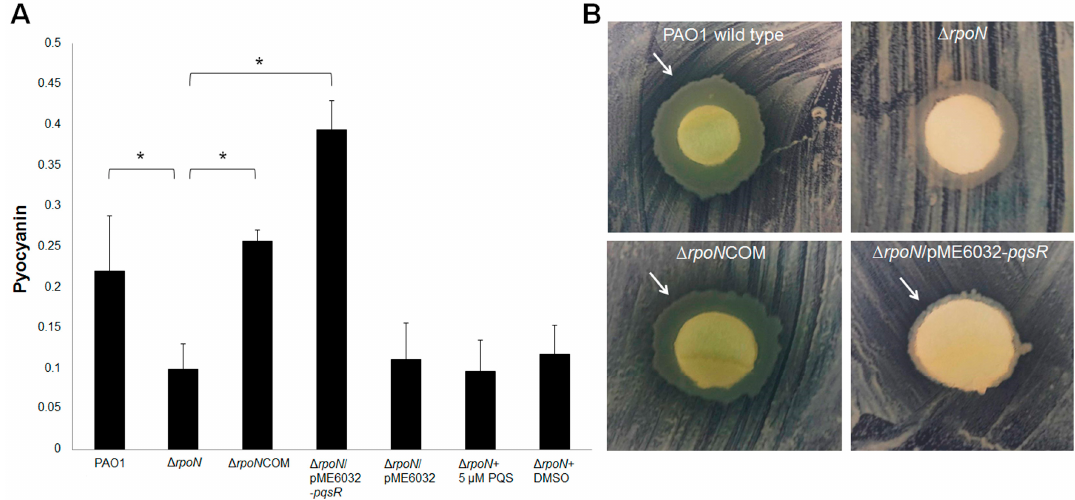
Figure 2. ( A ) Pyocyanin produced by PAO1 wild-type, ∆ rpoN , Δ rpoN COM, ∆ rpoN /pME6032- pqsR and Δ rpoN /pME6032 was determined by the chloroform extraction method. Means and S.D. from triplicate experiments are shown. Pyocyanin absorbance at OD 520 nm was normalized by culture cell density OD 600 nm . Student’s t -test was performed for testing differences between groups. * p ≤ 0.05; ( B ) Inhibition of the growth of Staphylococcus aureus 15981 by (i) PAO1; (ii) ∆ rpoN ; (iii) Δ rpoN COM; and (iv) Δ rpoN/ pME6032 -pqsR on LB agar plates. White arrows indicate the inhibitory zones of growth.